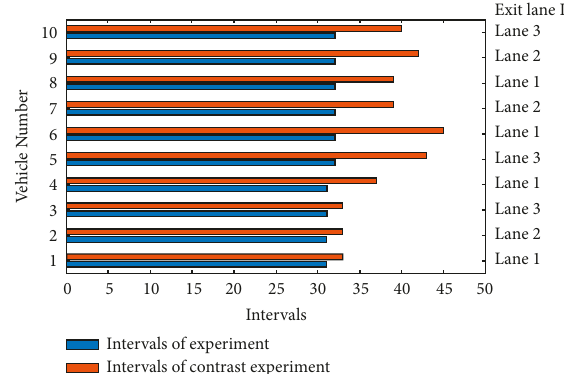
Figure 10: Total travel time of the